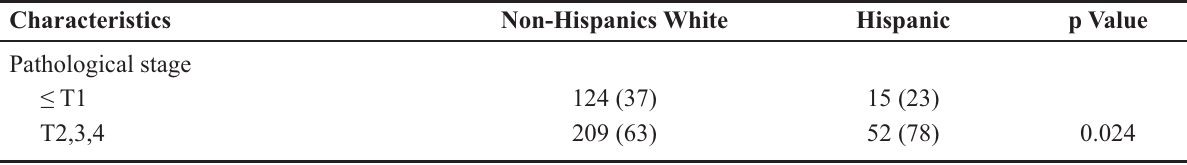
Table 3 – Pathological T stage at Radical Cystectomy in Hispanic and non-Hispanic white patients. Characteristics